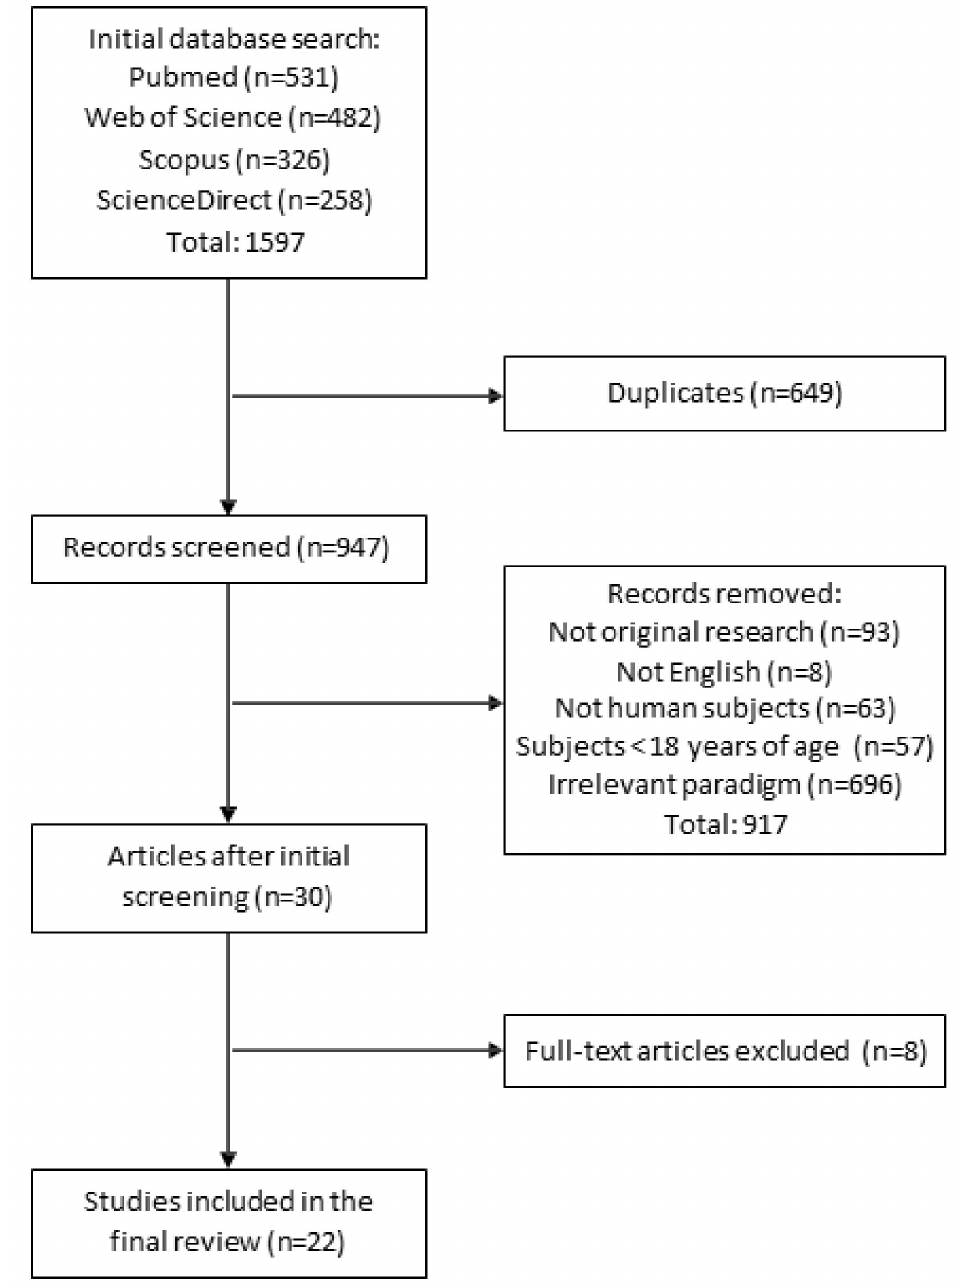
Figure 1. The schema of the search process and study